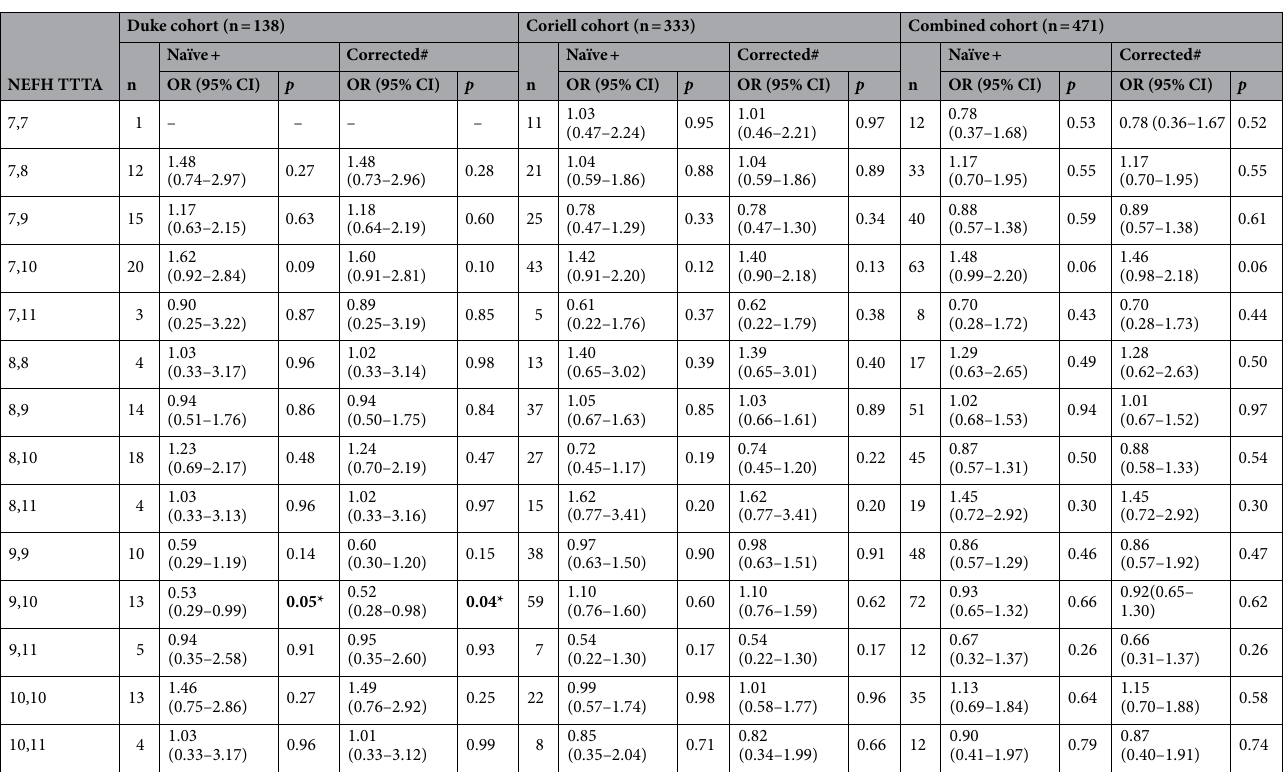
Table 3. Corrected regression models evaluating the association between NEFH TTTA genotypes and disease risk in two sporadic ALS cohorts. + Data taken from binary logistic regression models without correction for covariates. # Data taken from binary logistic regression models with correction for patient sex. P and OR (95% CI) values are calculated for the comparison to all other genotypes. The following genotypes were excluded form analysis due to low frequency: 6,7; 8,12; 9,15; 10,13; 11,11. OR, odds ratio; CI, confidence interval, p , statistical significance. Values in bold with * denote statistical significance p <